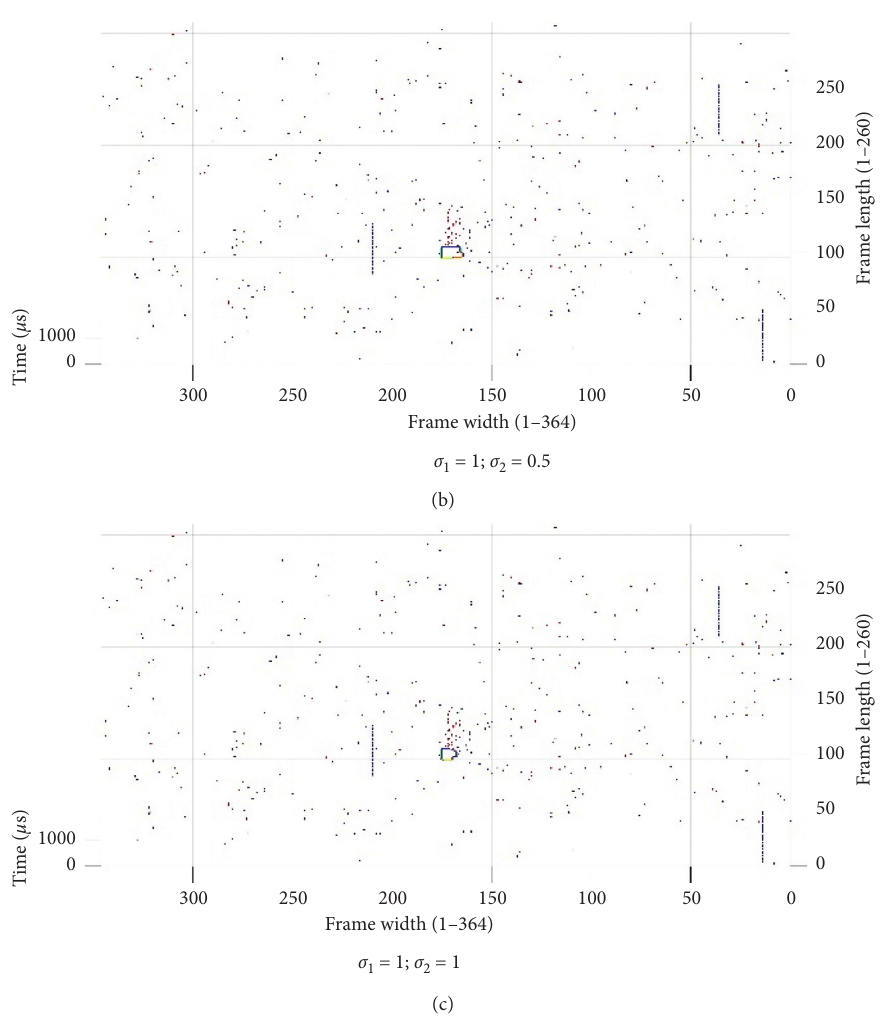
Figure 7: Object events obtained with different σ